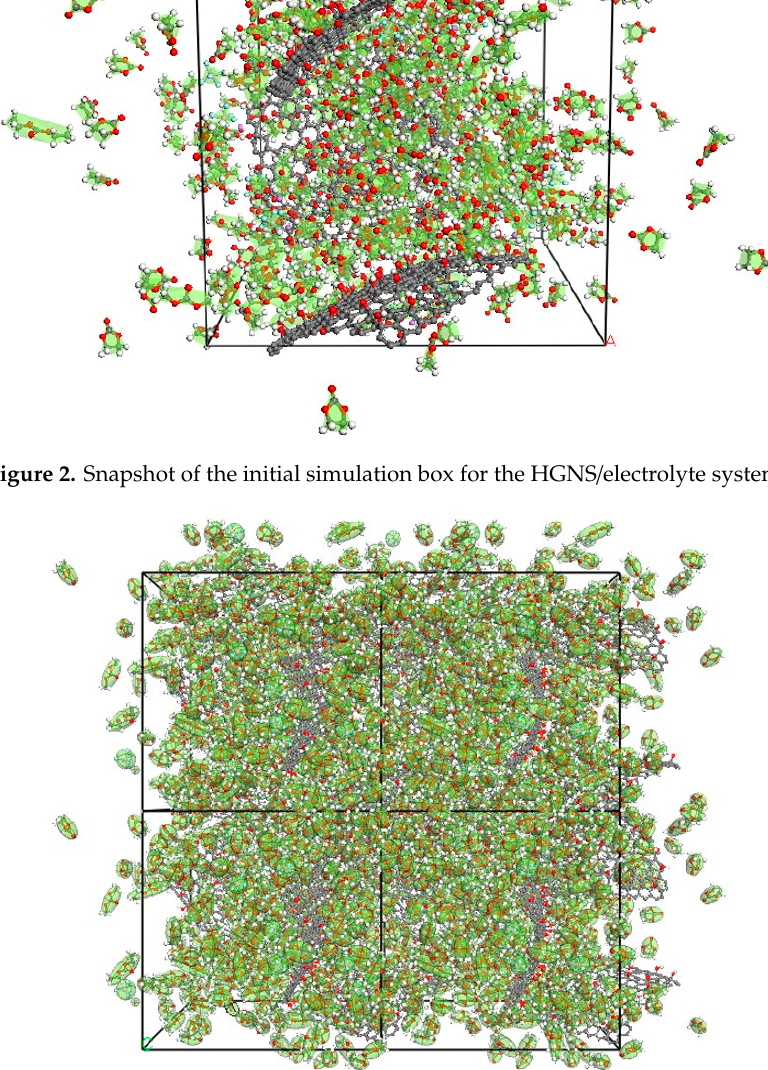
Figure 3. Snapshot of the HGNS/electrolyte system for the final-size box in thermal equilibrium.